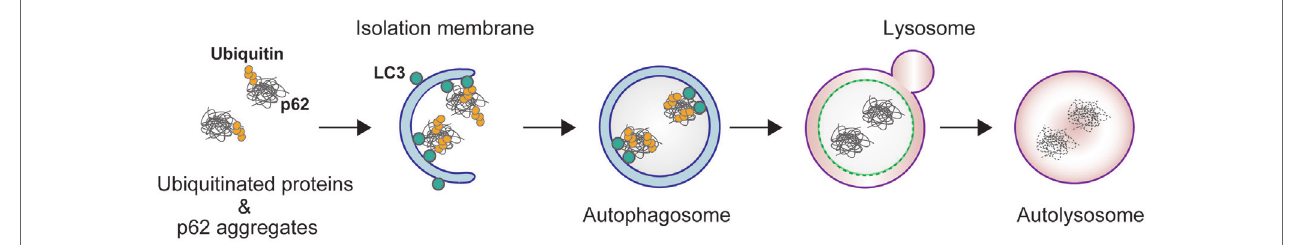
FigURe 1 | p62-mediated selective autophagy. p62 interacts with ubiquitinated proteins through its C-terminal ubiquitin-associated (UBA) domain, and forms aggregates through its N-terminal Phox and Bem1 domain. The resulting protein aggregates are tethered to the autophagosome by direct interaction of p62 and light chain 3 localized on the isolation membrane. The isolation membrane elongates and sequesters p62 and ubiquitin into the autophagosome. The autophagosome fuses with lysosome to form an